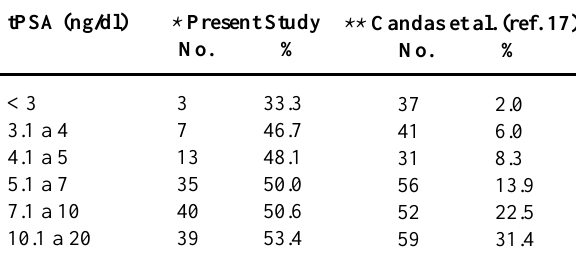
* = Population whose biopsy was indicated by change in any parameter for PSA assessment; ** = Screening work for detec- tion of PCa without considering PSA